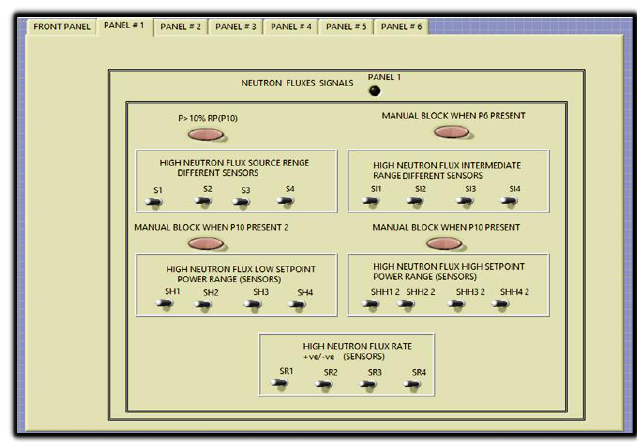
Fig. 9. ACP1000 neutronics parameters display system in